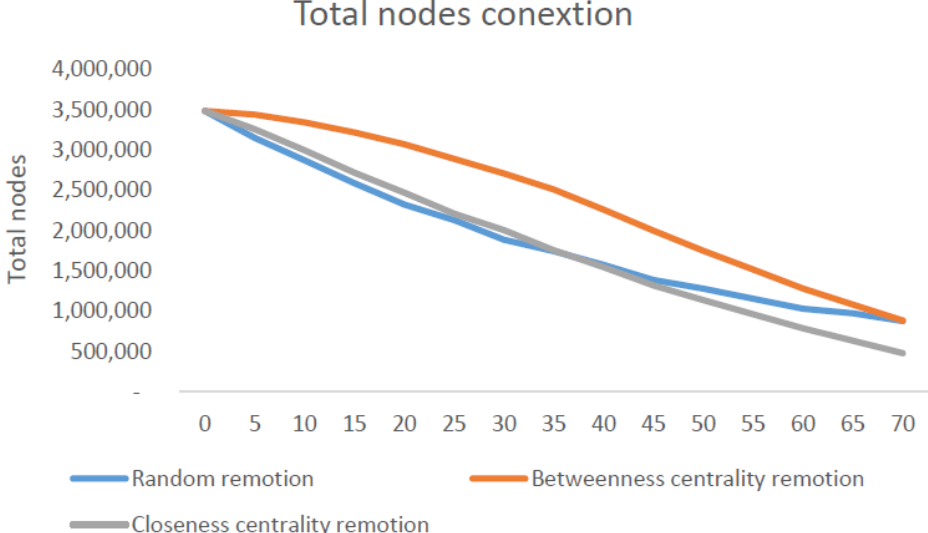
Figure 13. Total connected nodes under random nodal remotion and strategic remotion.